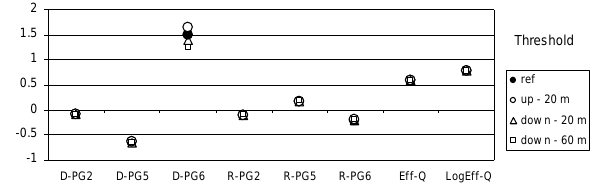
Figure 10. Mean error (D) and log of relative range of variations (R) of water table depth, computed for a reference case considering different slope positions of the threshold, using the threshold spatial model of variation in saturated hydraulic conductivity, for three wells – PG2 (bottom), PG5 (midslope) and PG6 (plateau) – during the tested period.